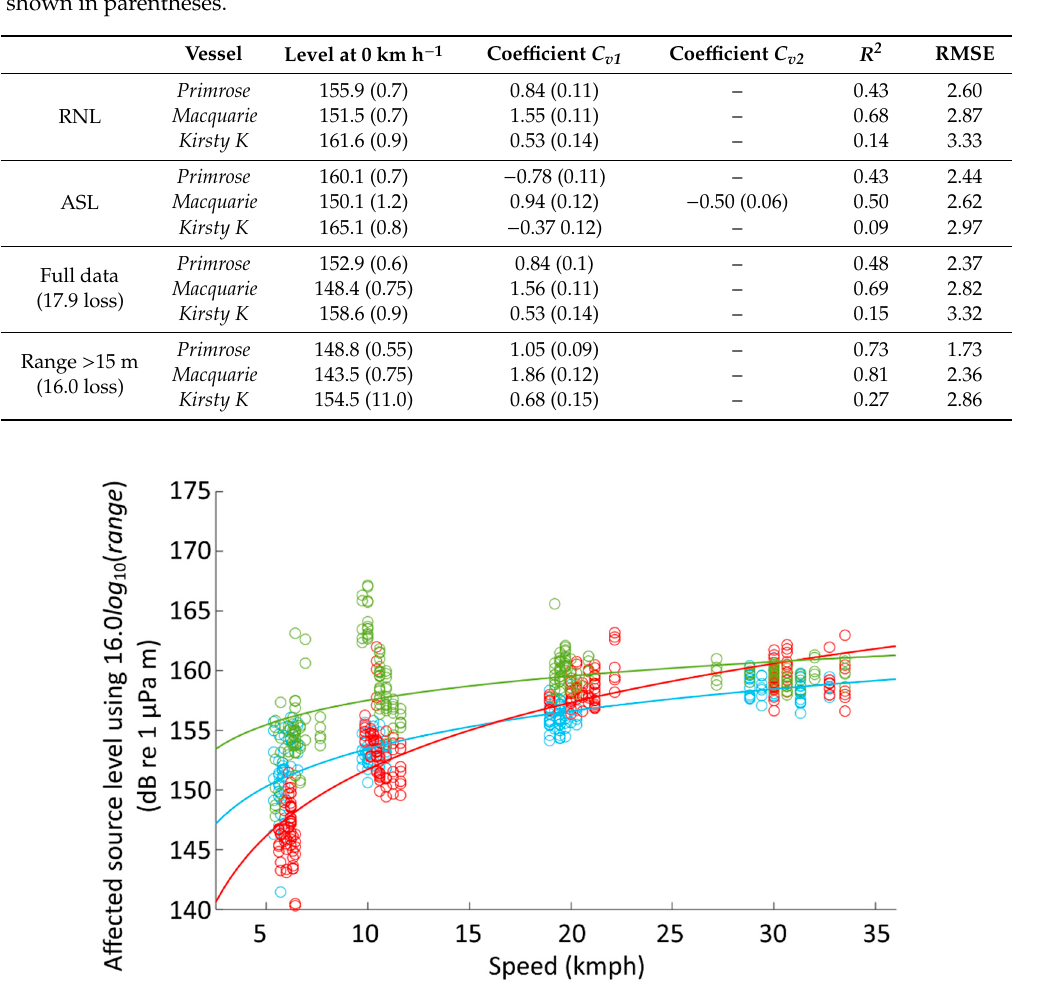
Figure 9. Relationships between affected source levels using the average linear regression-determined propagation loss across all vessels, excluding ranges below 15 m and speed for the Primrose (blue circles), Macquarie (red circles) and Kirsty K (green circles).